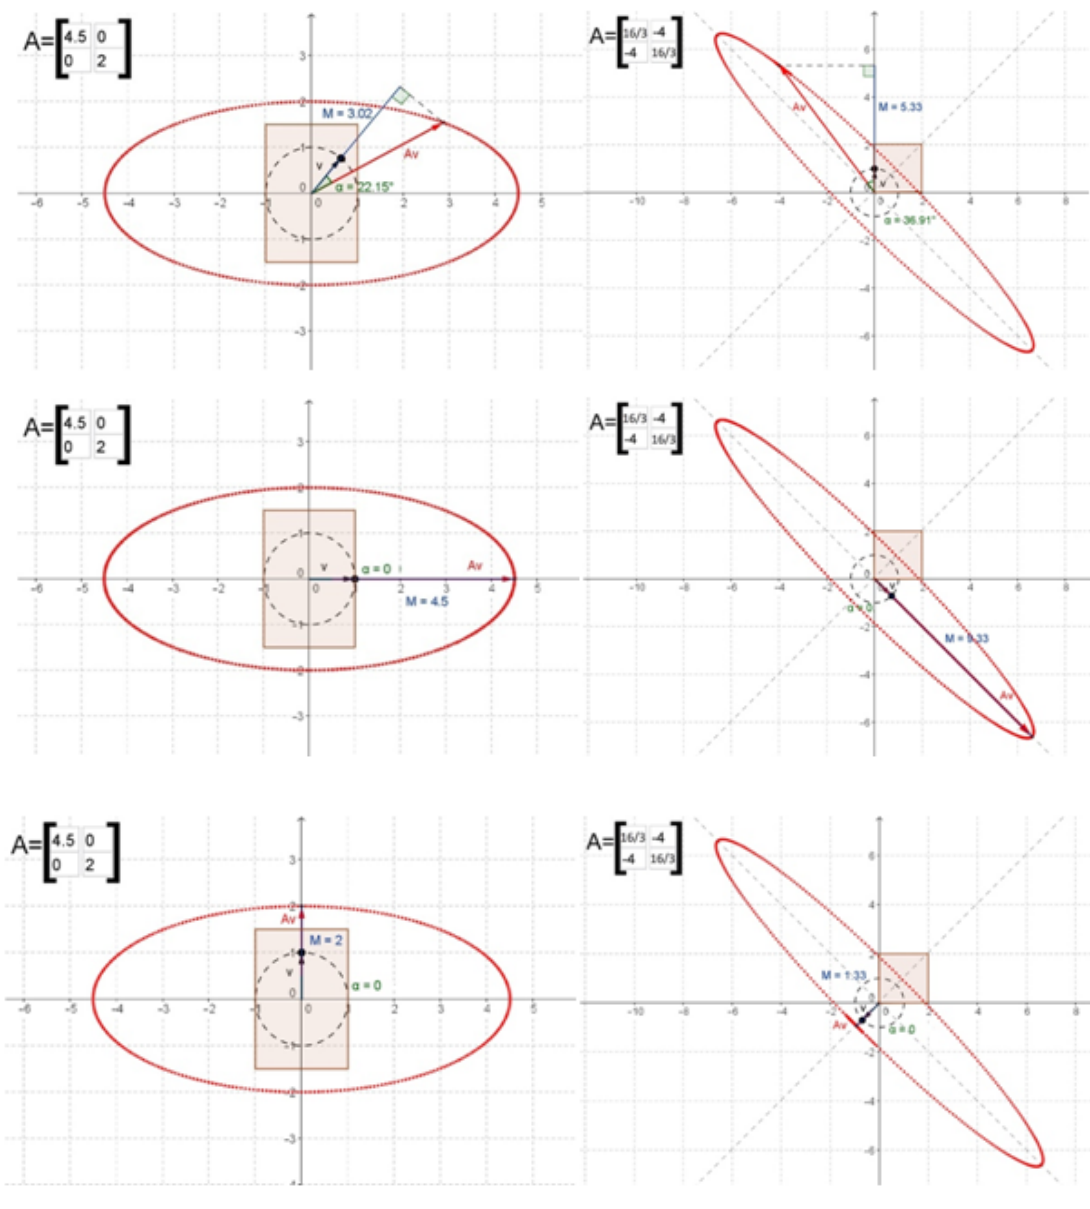
Figure 3. GeoGebra applet to calculate moments of